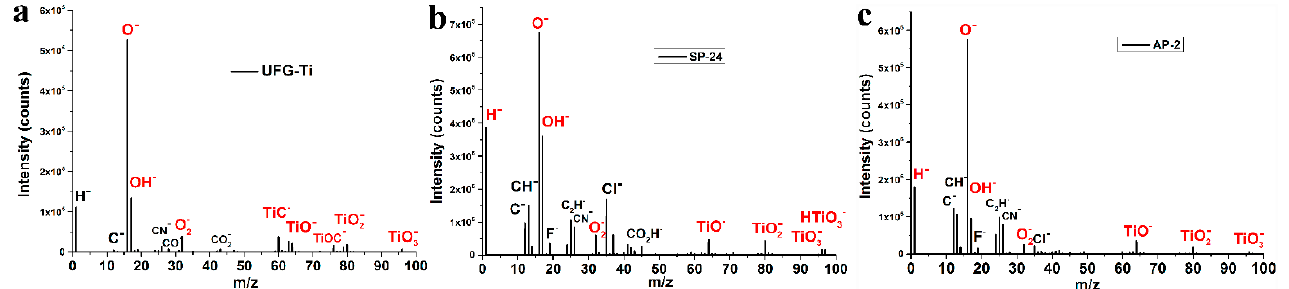
Figure 3. TOF ‐ SIMS spectra of negative ions: ( a ) UFG ‐ Ti; ( b ) UFG ‐ SP ‐ 24; ( c ) UFG ‐ AP ‐